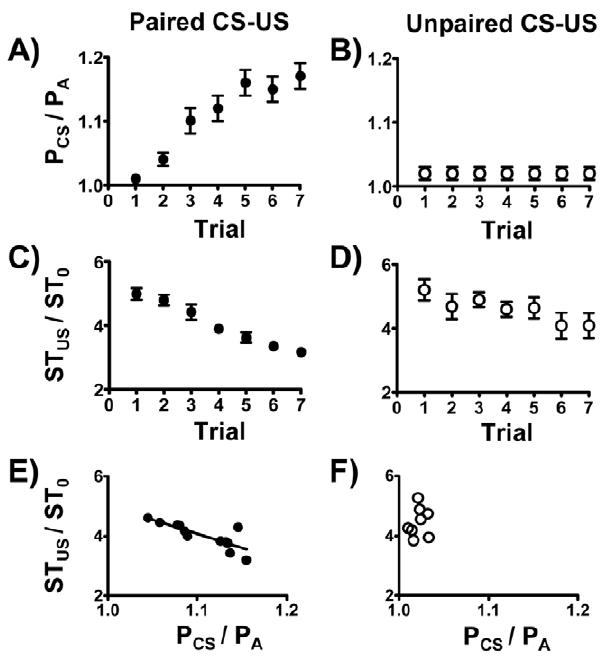
Figure 3. P CS /P A and ST US /ST 0 in the learning session. P CS /P A represents the CS-induced BP response, while ST US /ST 0 represents the US-induced sympathetic tone response. Both parameters show learning trial-dependent changes under paired CS-US conditions, but not under unpaired CS-US conditions (A–D). Additionally, the trial-averaged values of these two parameters negatively correlate with each other under paired CS-US conditions, but not under unpaired CS-US conditions (E, F). Results were analyzed by Pearson’s correlation analysis for individual group.